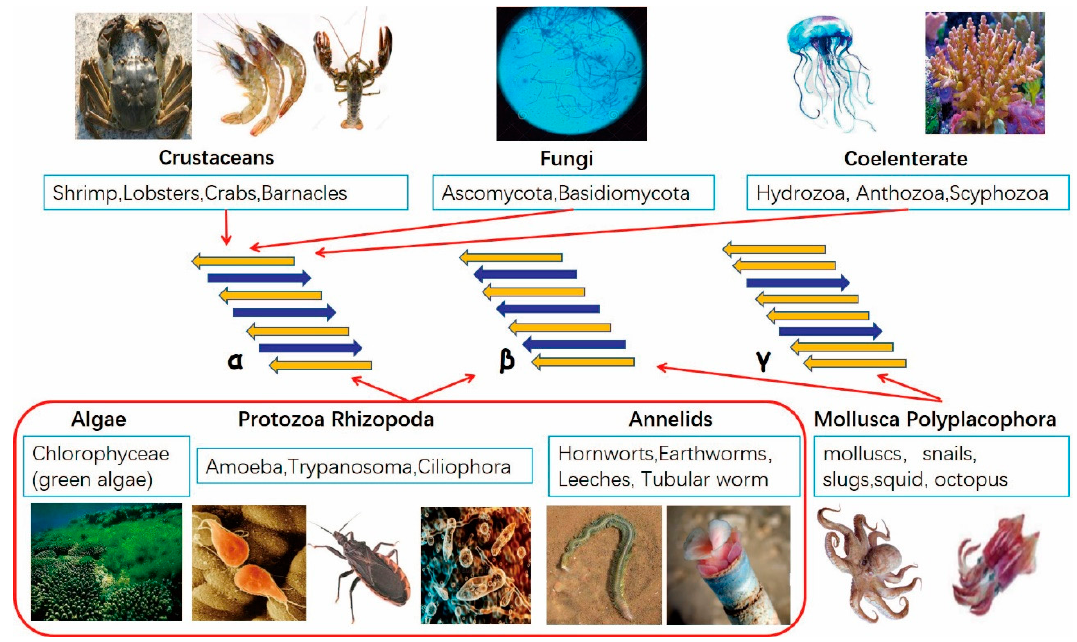
Figure 2. The crystalline structure of chitosan and its main marine organisms sources.